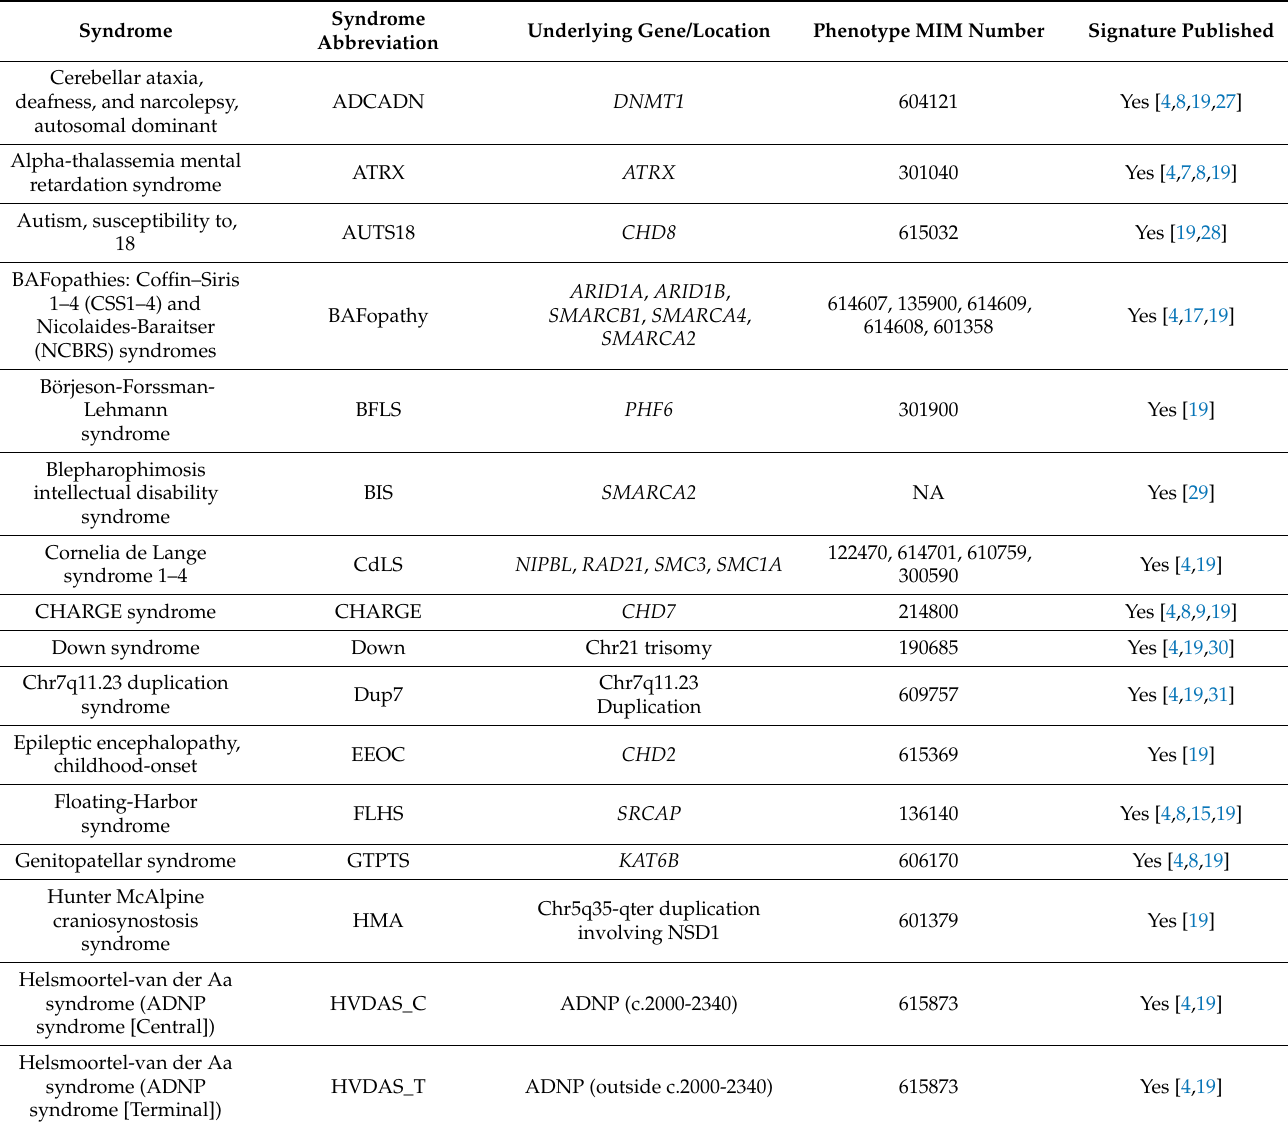
Table 2. List of syndromes with a defined episignature, used for training a more accurate